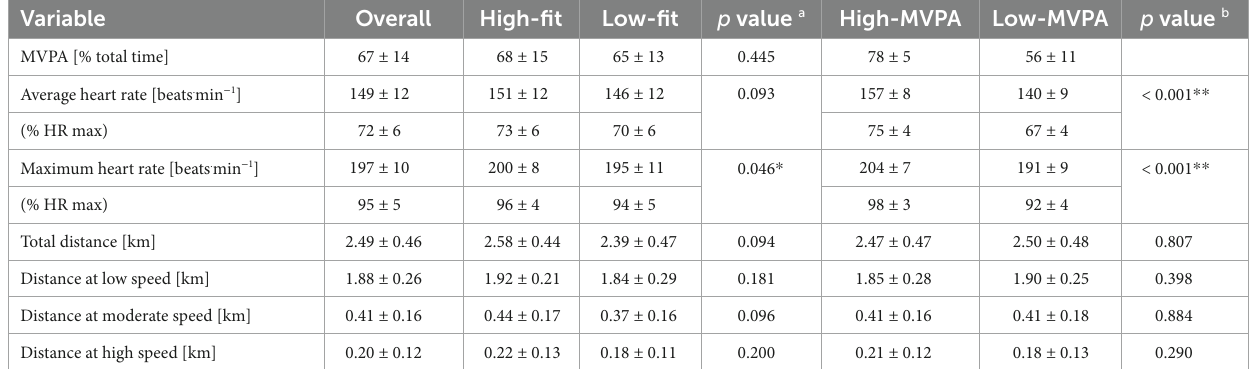
TABLE 2 Descriptive data and inferential statistics for the PE lessons overall, as well as for the high fit and low fit groups, and the high MVPA and low MVPA groups.